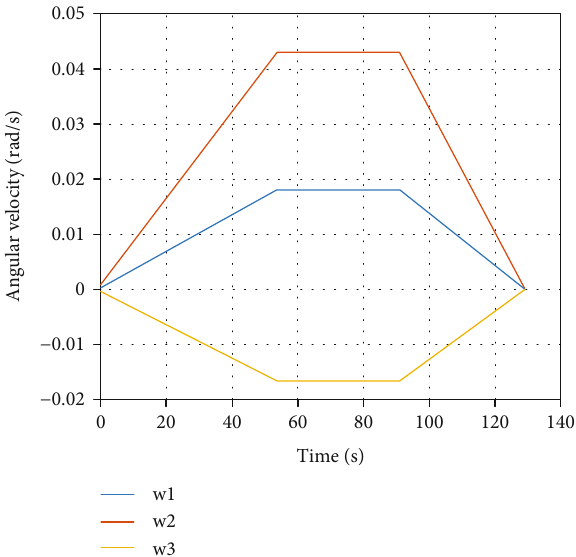
Figure 5: Angular velocity time history based on the cross- mutation grey wolf